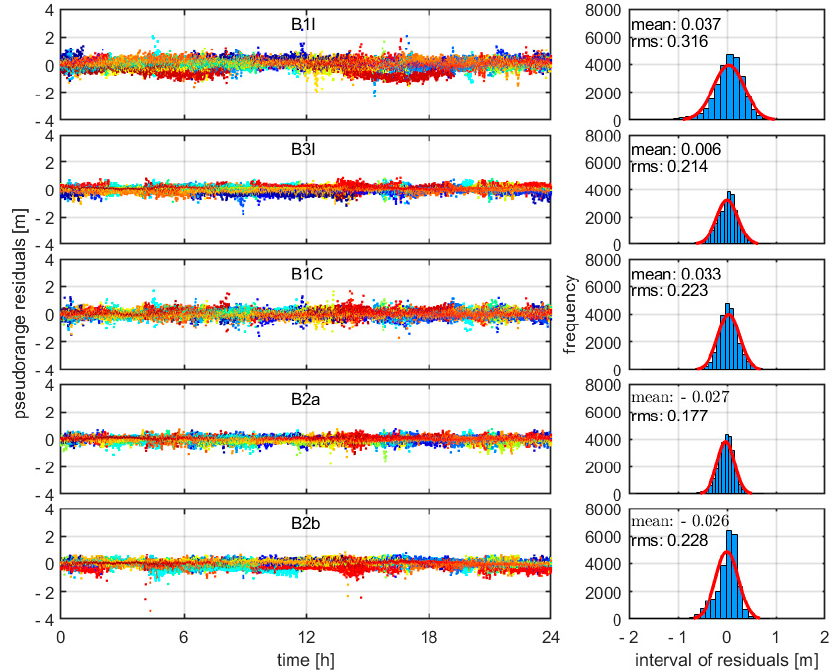
Figure 3. The pseudorange residuals for BDS-3 UC-PPP of IFBs for stochastic modeling of random constant for station KRGG on DOY 001, 2022. The residuals of each satellite are represented with different colors. The right part of each subfigure shows the histogram of the residuals and the fitted normal density function (red line). Table 3. The means and RMS of the pseudorange residuals among different IFCB handling schemes.